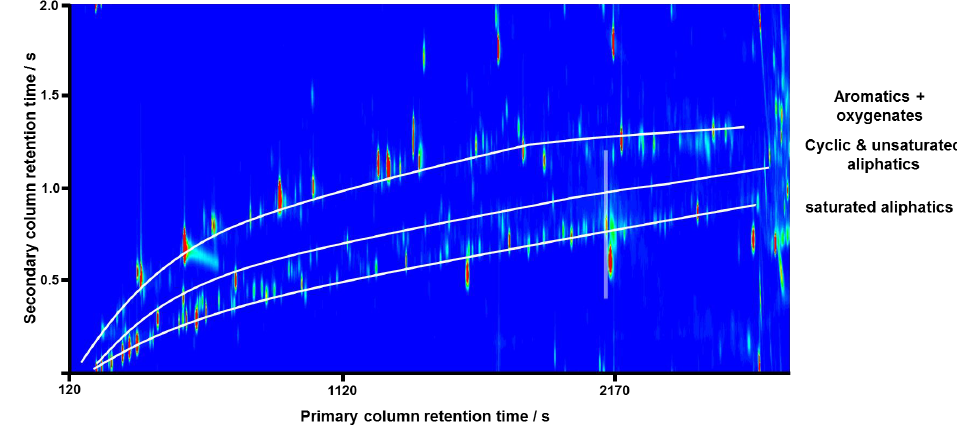
Figure 5. Typical GC × GC-TOFMS chromatogram from RONOCO highlighting the functional group pattern formation extracted and viewed in isolation (for example m/z 91 for